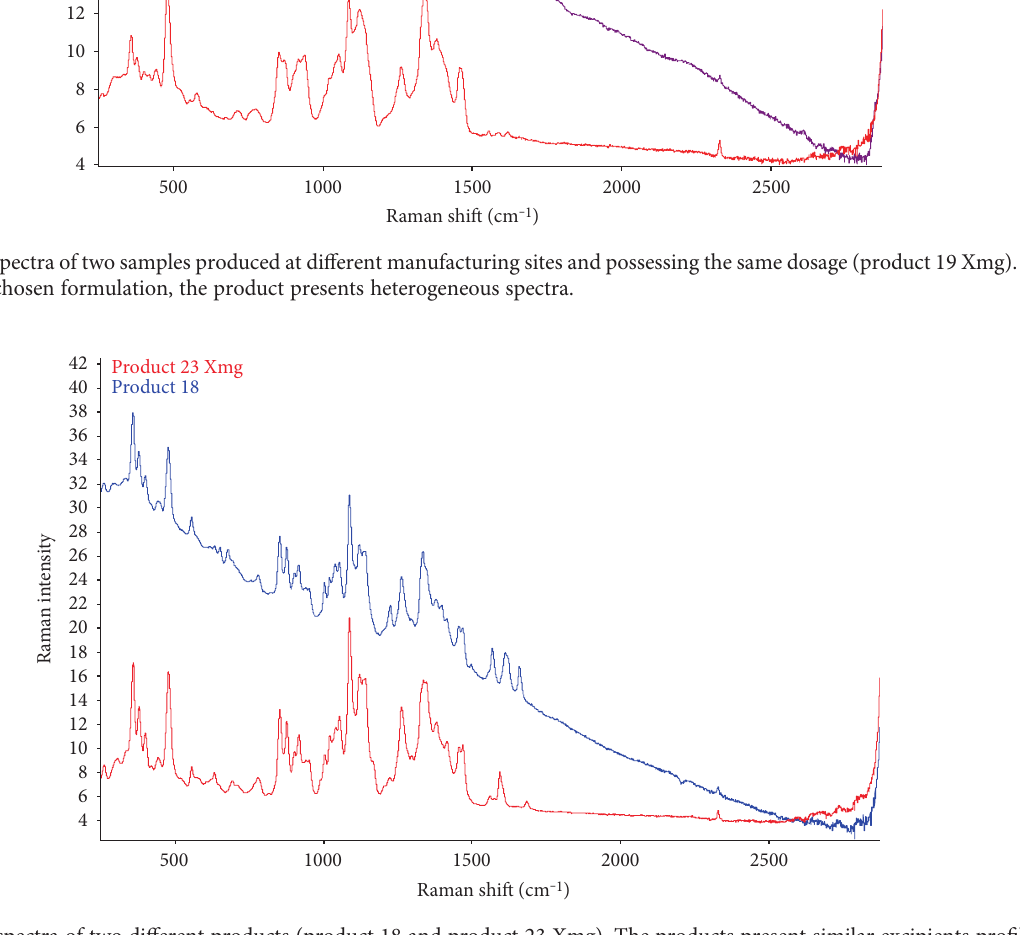
Figure 3: Raman spectra of two di ff erent products (product 18 and product 23 Xmg). The products present similar excipients pro fi les and thus close Raman